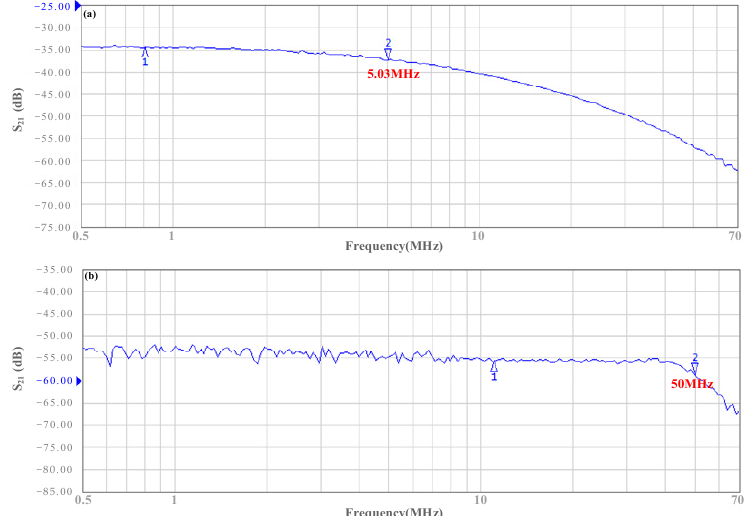
Figure 8. S 21 parameter of the proposed UOWC system. ( a ) Without pre-equalizer; ( b ) with pre- equalizer.